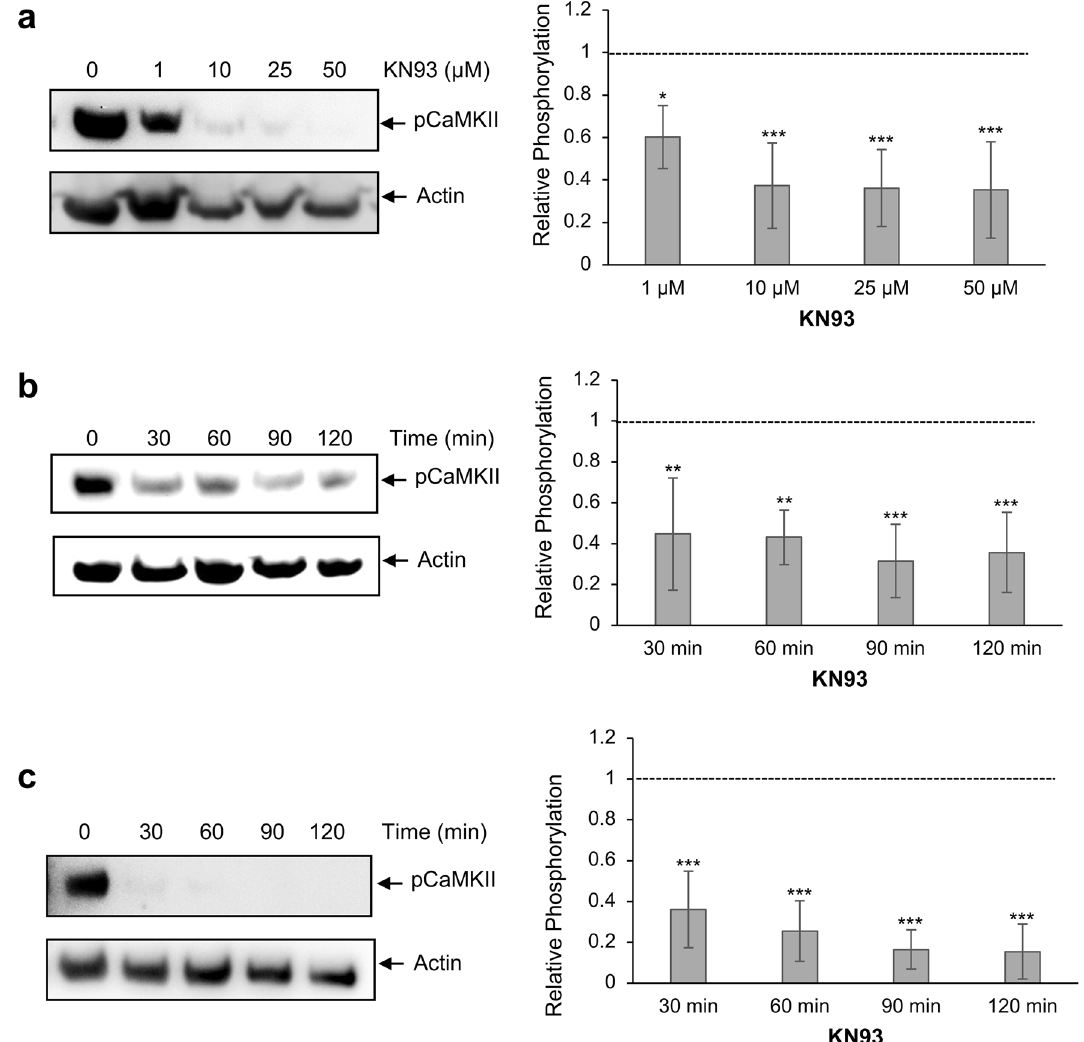
Figure 2. Inhibition of Schistosoma mansoni CaMKII phosphorylation with the CaMKII inhibitor, KN93. Either intact 24 h in vitro cultured schistosomula (~ 1000 per treatment) ( a , b ), or schistosomula homogenates ( c ), were exposed to ( a ) increasing concentrations of KN93 for 2 h, or ( b , c ) 10 µM KN93 for increasing durations, and the effects of KN93 on CaMKII phosphorylation evaluated by western blotting with anti- phospho CaMKII (Thr 286 ) antibodies; actin was used as an inter-lane loading control. Representative blots are shown. Mean CaMKII phosphorylation levels (n = 4, ± SD; graphs) were determined and phosphorylation change calculated relative to the phosphorylation levels of controls (0) that were assigned a value of 1 (shown as dotted line); * p ≤ 0.05, ** p ≤ 0.01, *** p ≤ 0.00 (ANOVA) when compared with control